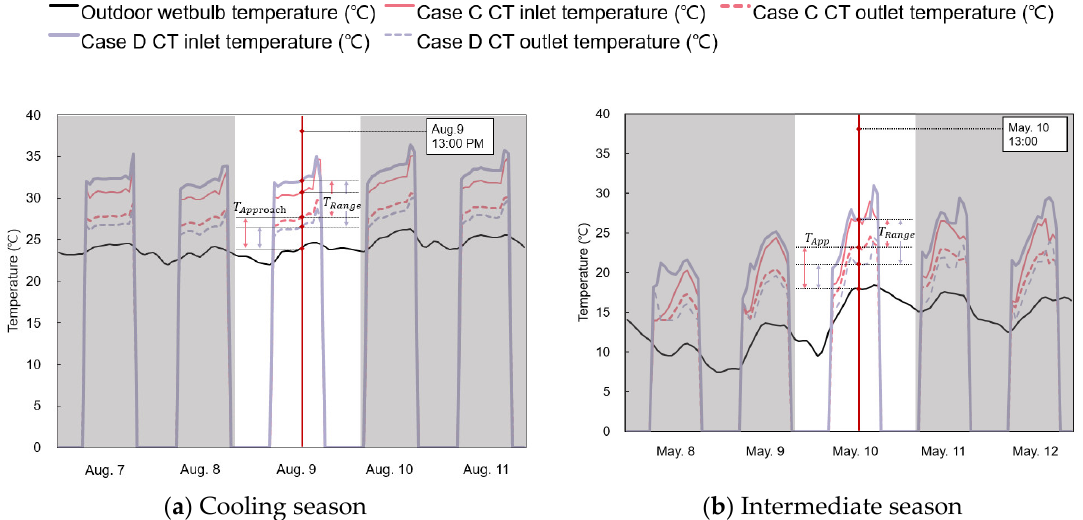
Figure 12. Weekly range and approach temperature for Cases C and D.